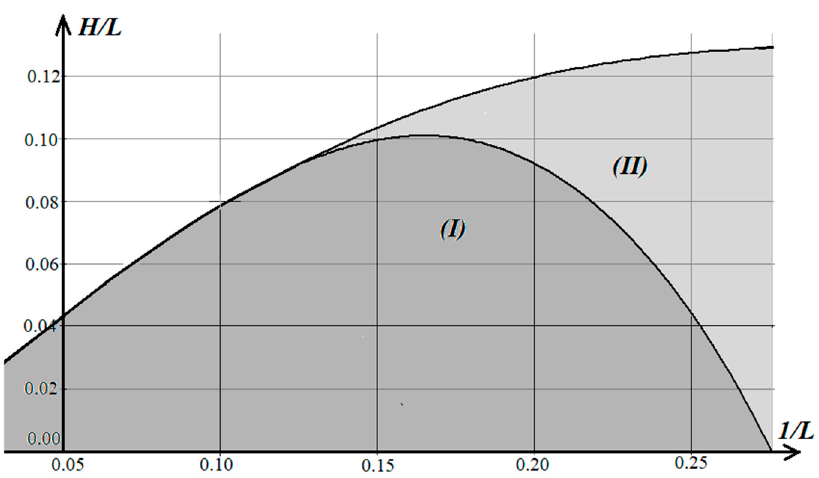
Figure 8. Permissible wave steepness versus wavelength: shadow zone ( I )—model BM, zones ( I ) plus ( II )—model FN.